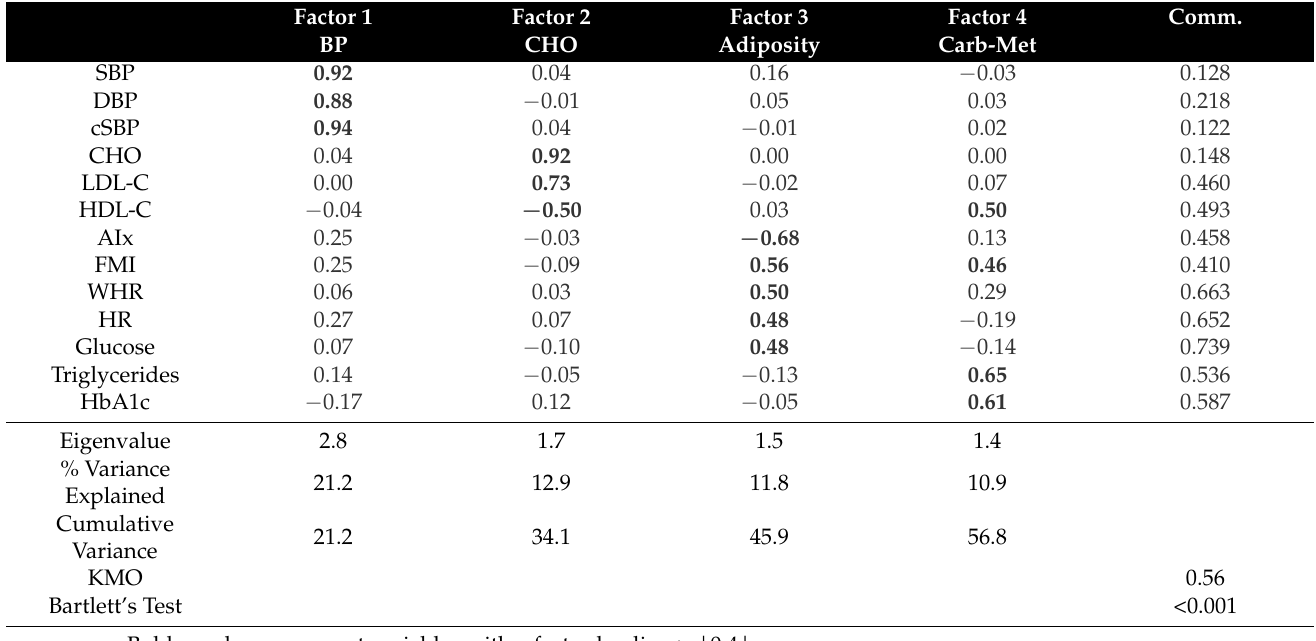
Table 2. Results of Factor Analysis to Identify Cardiometabolic